Question: Write the caption for this figure.
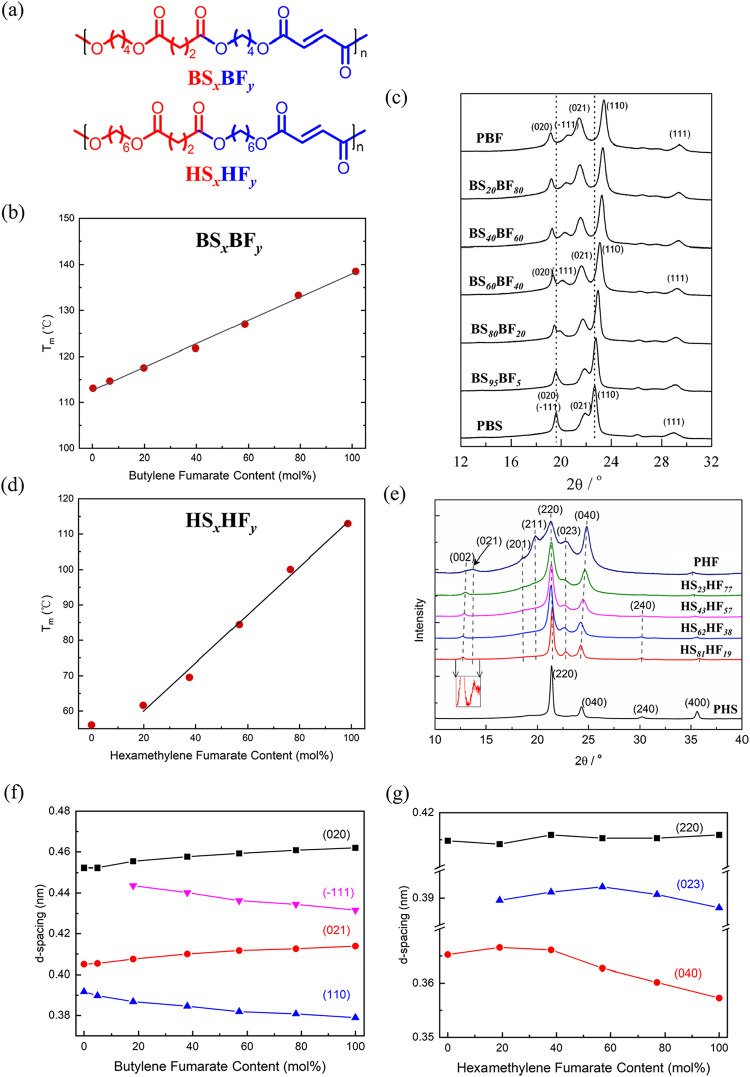
Answer: Examples of isomorphic-like behavior in BS x BF y and HS x HF y chemical structures in (a). The T m (b, d) and d -spacing (f, g) vs comonomer content is shown for BS x BF y (b, f) and HS x HF y (d, g), and the WAXS pattern is shown in (c) BS x BF y and (e) HS x HF y . In both systems, thermal continuity alone is insufficient to conclusively demonstrate strict isomorphism , as a distinct common crystalline phase separate from the parent lattices and their known polymorphs is not clearly observed. Figure 5 is adapted from refs and . Copyright 2012 American Chemical Society and Copyright 2014 Elsevier.